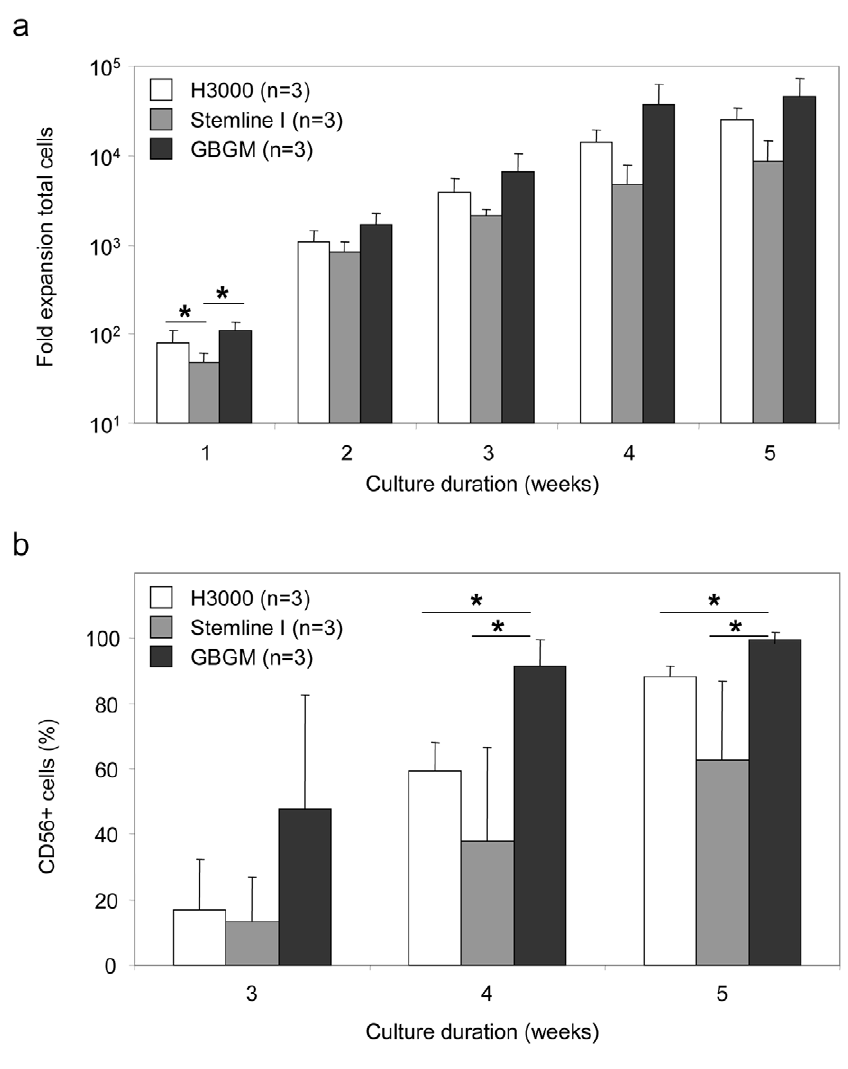
Figure 3. Superior expansion of UCB-derived CD56 + NK cells using a novel clinical grade medium. The new GBGM H medium was compared with two previously tested media in the NK cell generation system according to Method II (see Figure 1). Cell cultures were weekly analyzed for cell numbers and phenotype using FCM. ( a ) Fold expansion of total cells after initial seeding of 1 6 10 4 CD34 + UCB cells was determined during 5 weeks of culture. Data represent the calculation based on the actual expansion rates of total cells and are displayed as mean 6 SD of three different experiments. ( b ) CD56 + cell frequency during the differentiation stage for three different media, which have been tested in parallel experiments using three UCB donors. Data are depicted as mean 6 SD. * represents a p-value of ,